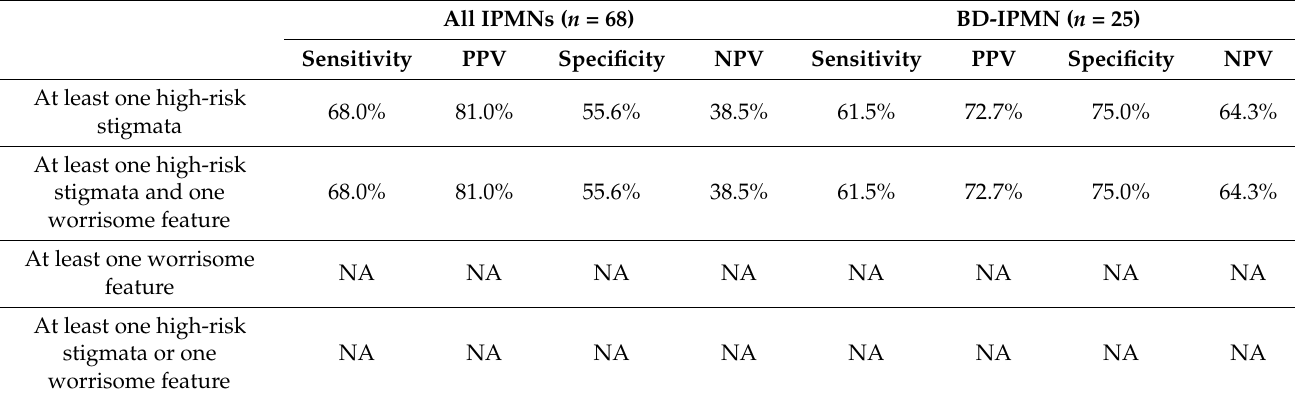
Table 6. Diagnostic performance of indications for resection according to the Fukuoka consensus guidelines on pancreatic cystic neoplasms stratified by patients with intraductal papillary mucinous neoplasms and patients with branch duct- intraductal papillary mucinous